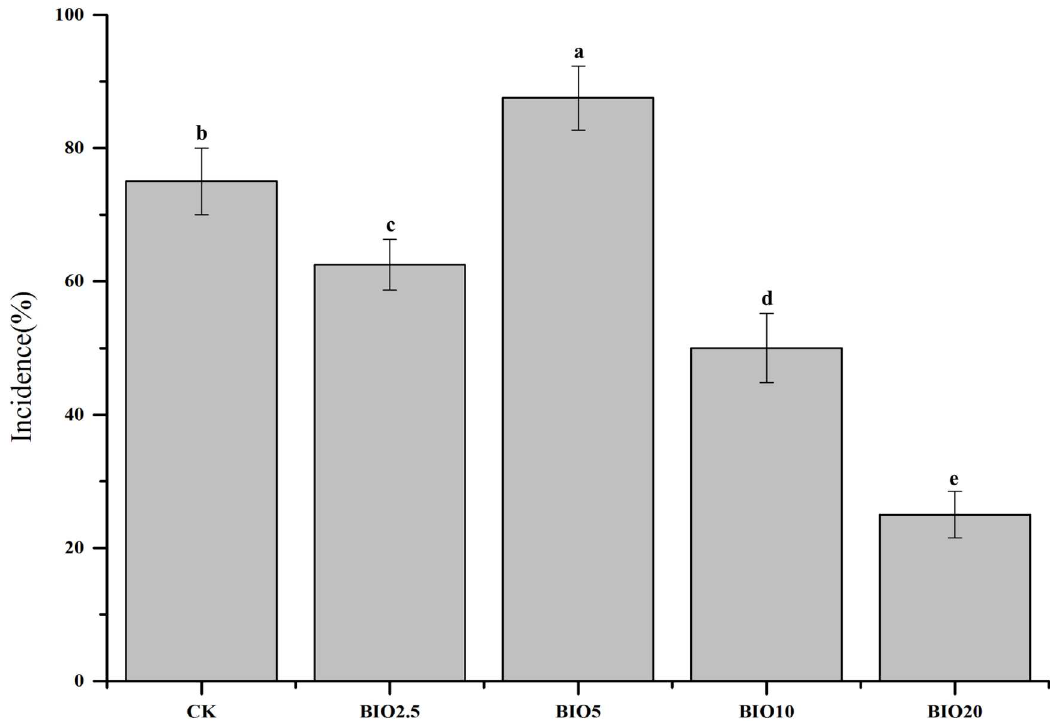
Fig 1. The disease incidence rate of cucumber Fusarium wilt. Columnswith different letters are significantly different accordingto Duncan’stest ( P <